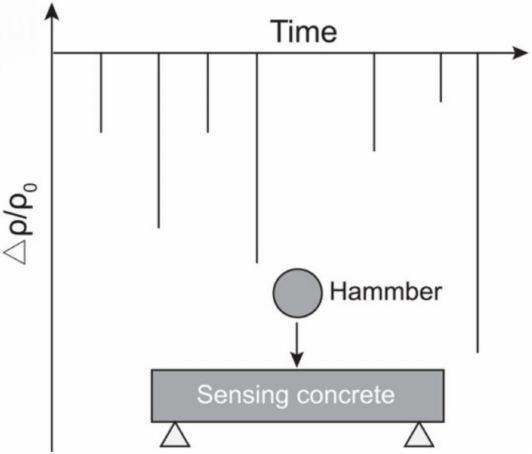
Figure 6. Self-sensing concrete under impact load. Reproduced with permission from [51], Journal of Applied Physics, 2019.